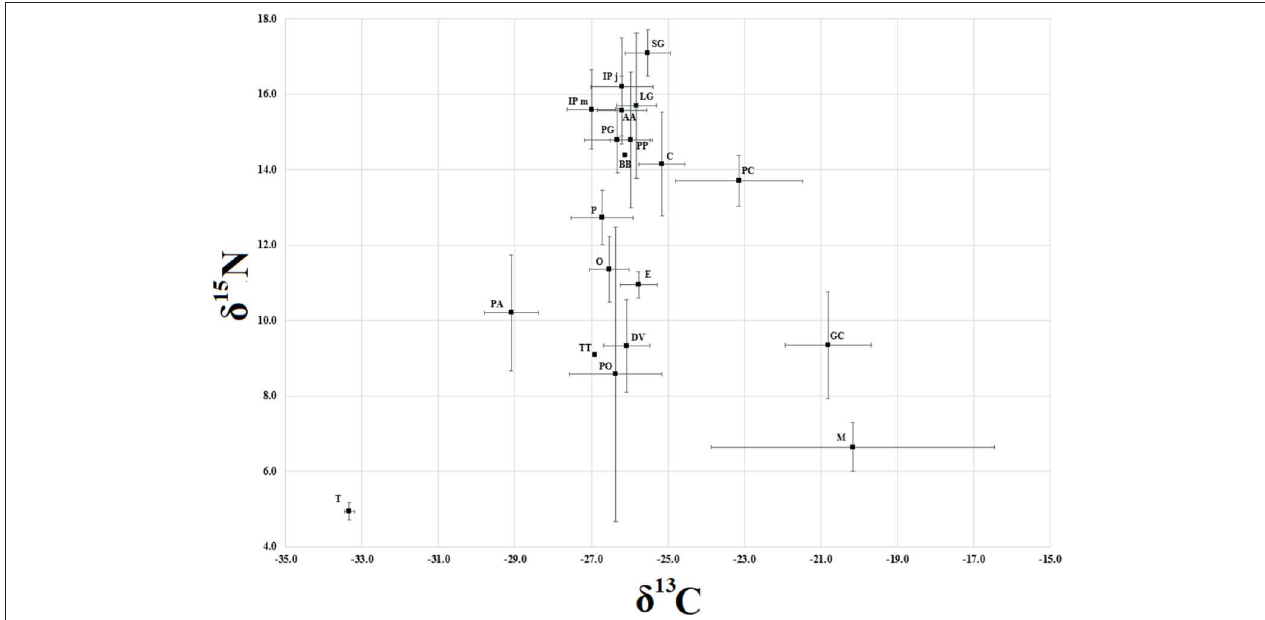
FIGURE 1 | Isotopic space scatterplot of the community. Species IDs: SG, Silurus glanis ; IPj, Ictalurus punctatus (juveniles); IPm, Ictalurus punctatus (matures); LG, Lepomis gibbosus ; AA, Alburnus alburnus ; PG, Padogobius sp.; PP, Pseudorasbora parva ; BB, Barbus barbus ; C, Cyprinus carpio ; PC, Procambarus clarkii ; P, Palaemon antennarius ; O, Odonata; E, Ephemeroptera; DV, Dikerogammarus villosus ; GC, Gyraulus chinensis ; PA, Phragmites australis ; T, tadpoles ( Pelophylax kl. esculentus ); TT, Tinca tinca ; M, Myriophyllum sp.; PO, Potamogeton sp. Each species is represented as mean (centroid), with bars representing standard